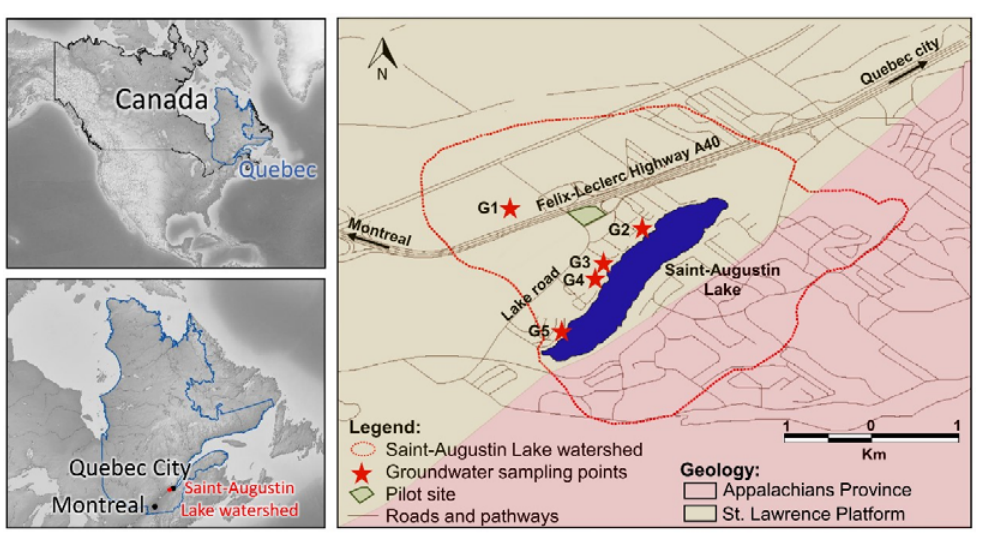
Figure 1. Groundwater sampling wells in Saint ‐ Augustin Lake watershed (Quebec) and geological context. Red stars represent groundwater sampling wells: G1 (road control); G2 (residential control); and G3 to G5 (study wells affected by road and residential areas). Pilot site to runoff desalination is also indicated in the picture.